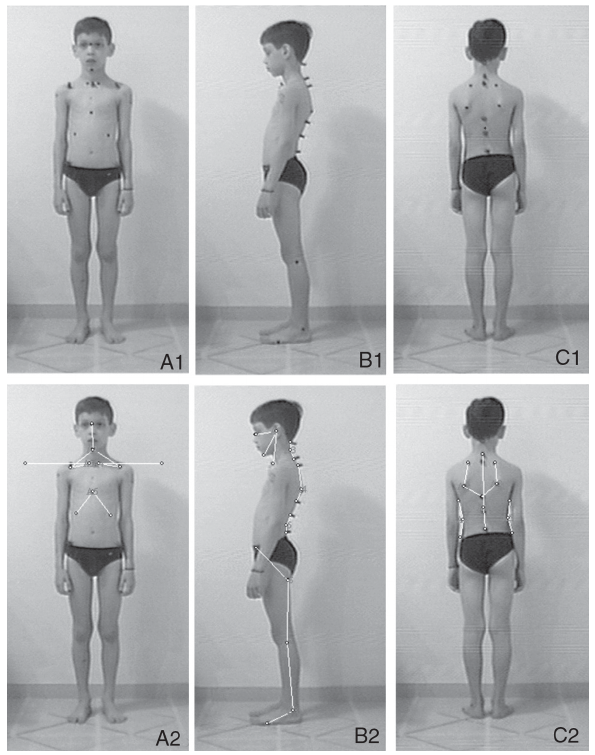
FIGURE 1 - Delineated anatomical points analyzed. A1, A2 – Anterior: (1,2) right and left glabella, mentum and coracoid process (RGMCP and LGMCP, respectively); (3,4) coracoid process, condylar angle and right and left horizontal (RCPCH and LCPCH, respectively); (5) Charpy’s angle (CA). B1, B2 – Profile: (1) glabella, external acoustic meatus and mentum (GMM); (2) glabella, external acoustic meatus and manubrium sterni (GMS); (3) C2, point of greatest cervical curvature and C7 (C2C7); (4) T2, point of greatest thoracic prominence and T9 (T2T9); (5) L1, point of greatest lumbar curvature and L5 (L1L5); (6) anterior superior iliac spine, gluteal line and lateral condyle of the knee (SGLK); (7) gluteal line, lateral condyle of the knee and lateral malleolus of the ankle (GLKA); (8) lateral condyle of the knee, lateral malleolus of the ankle and 5th metatarsal diaphysis (KAM). C1, C2 – Posterior: (1) vertebral line C7, T12 and L5 (C7T12L5); (2,3) right (RTT) and left (LTT) talus triangle; (4,5) right and left superior scapular angle, inferior scapular angle and T9 (RSIST9 and LSIST9,